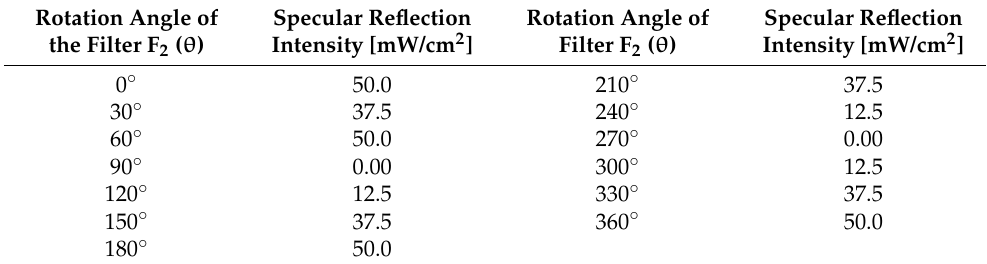
Table 1. Analysis of changes in specular reflection intensity according to the rotation angle of filter (F 2 ).